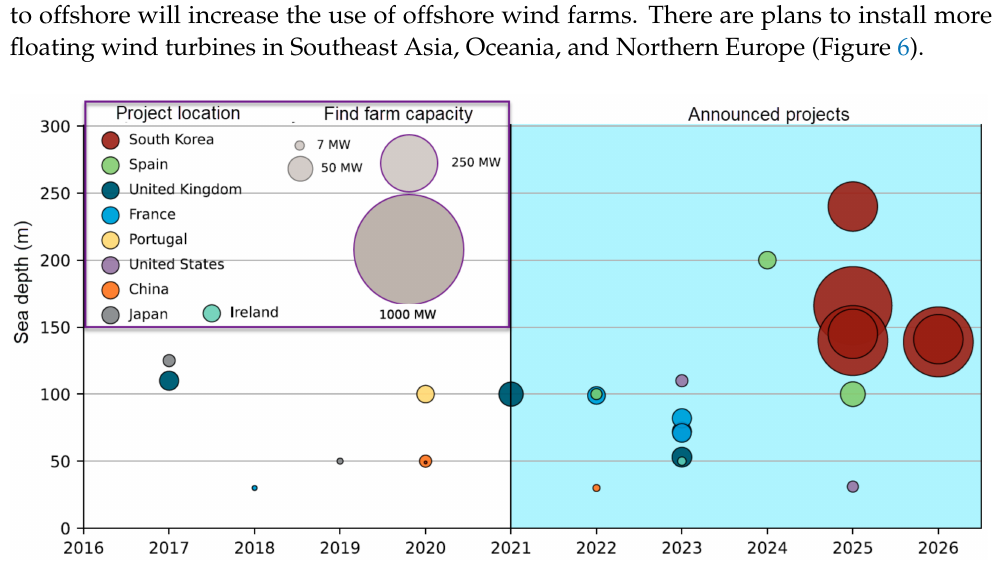
Figure 6. Global floating offshore wind energy projects by depth, country, and project size